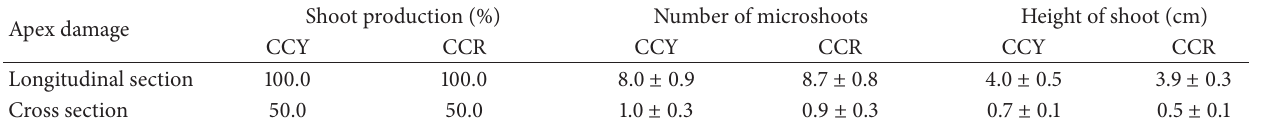
Table 5: Effects of apex damage on production of microshoots in C. crotalifera (CCR and CCY).